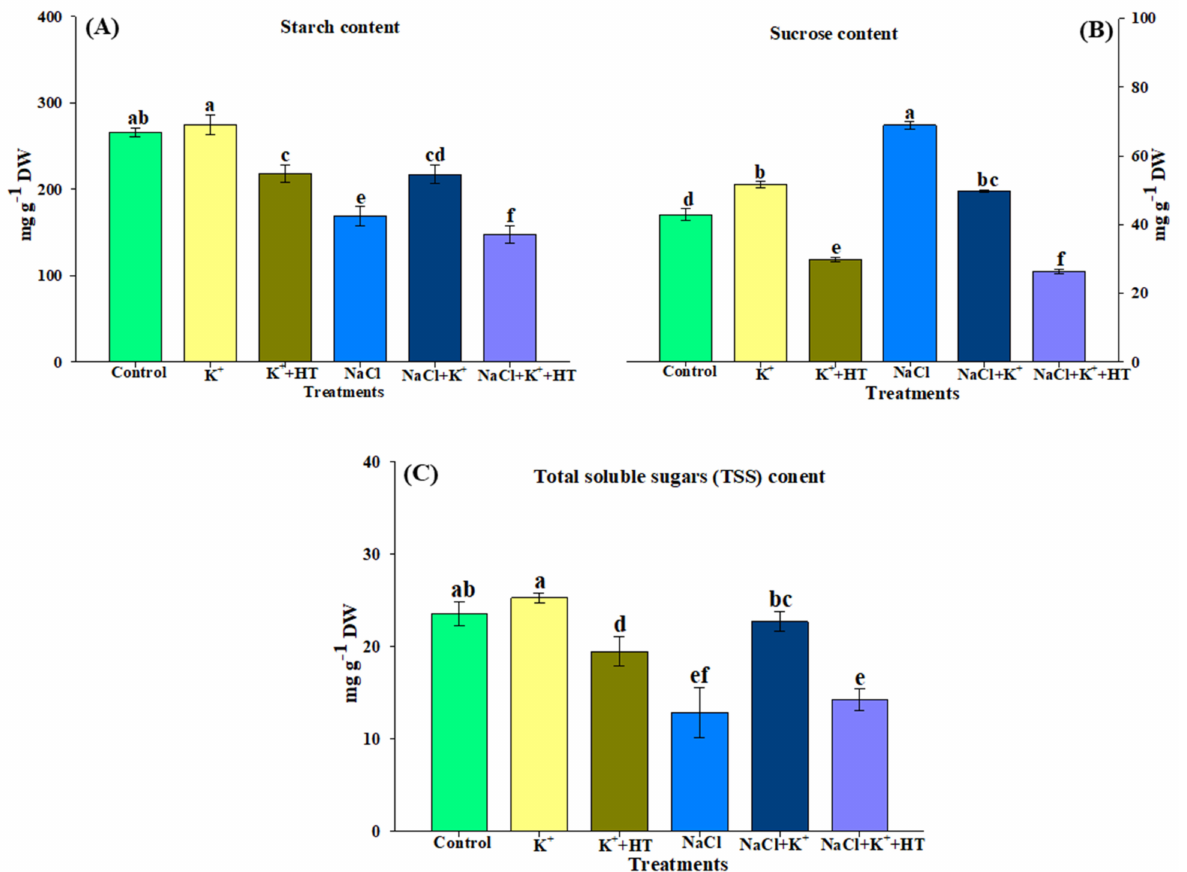
Figure 10. Effect of K + and NaCl on the concentration of carbohydrates in tomato roots. ( A ) Starch content, ( B ) sucrose content, and ( C ) total soluble sugar (TSS) content in tomato roots. Double deionized water (control), 5 mM K 2 CO 3 (K + ), 100 mM NaCl (NaCl), 1 mM hypotaurine (HT: H 2 S scavenger). Values are means of five independent replicates, with bars indicating SE. Bars with different letters indicate that differences were statistically significant at p < 0.05